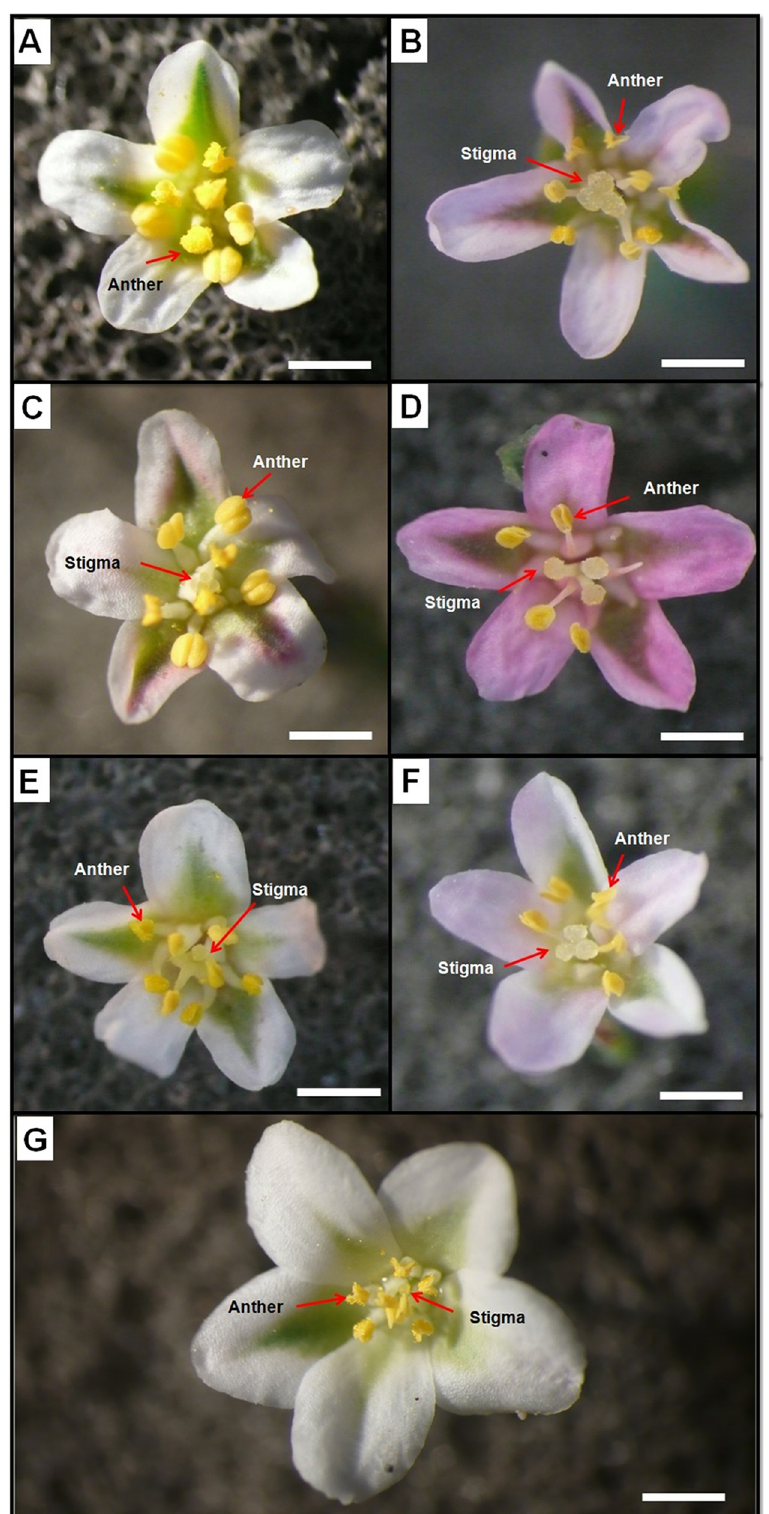
Fig 1. Flower morphology. Flowers of the long (LS) and short (SS) style morphs of P . equisetiforme var. graecum (a: SS, b: LS), P . equisetiforme var. peyerinhoffi (c: SS, d: LS), P . aviculare (e: SS, f: LS), and P . maritimum , (g). Scale bars = 1